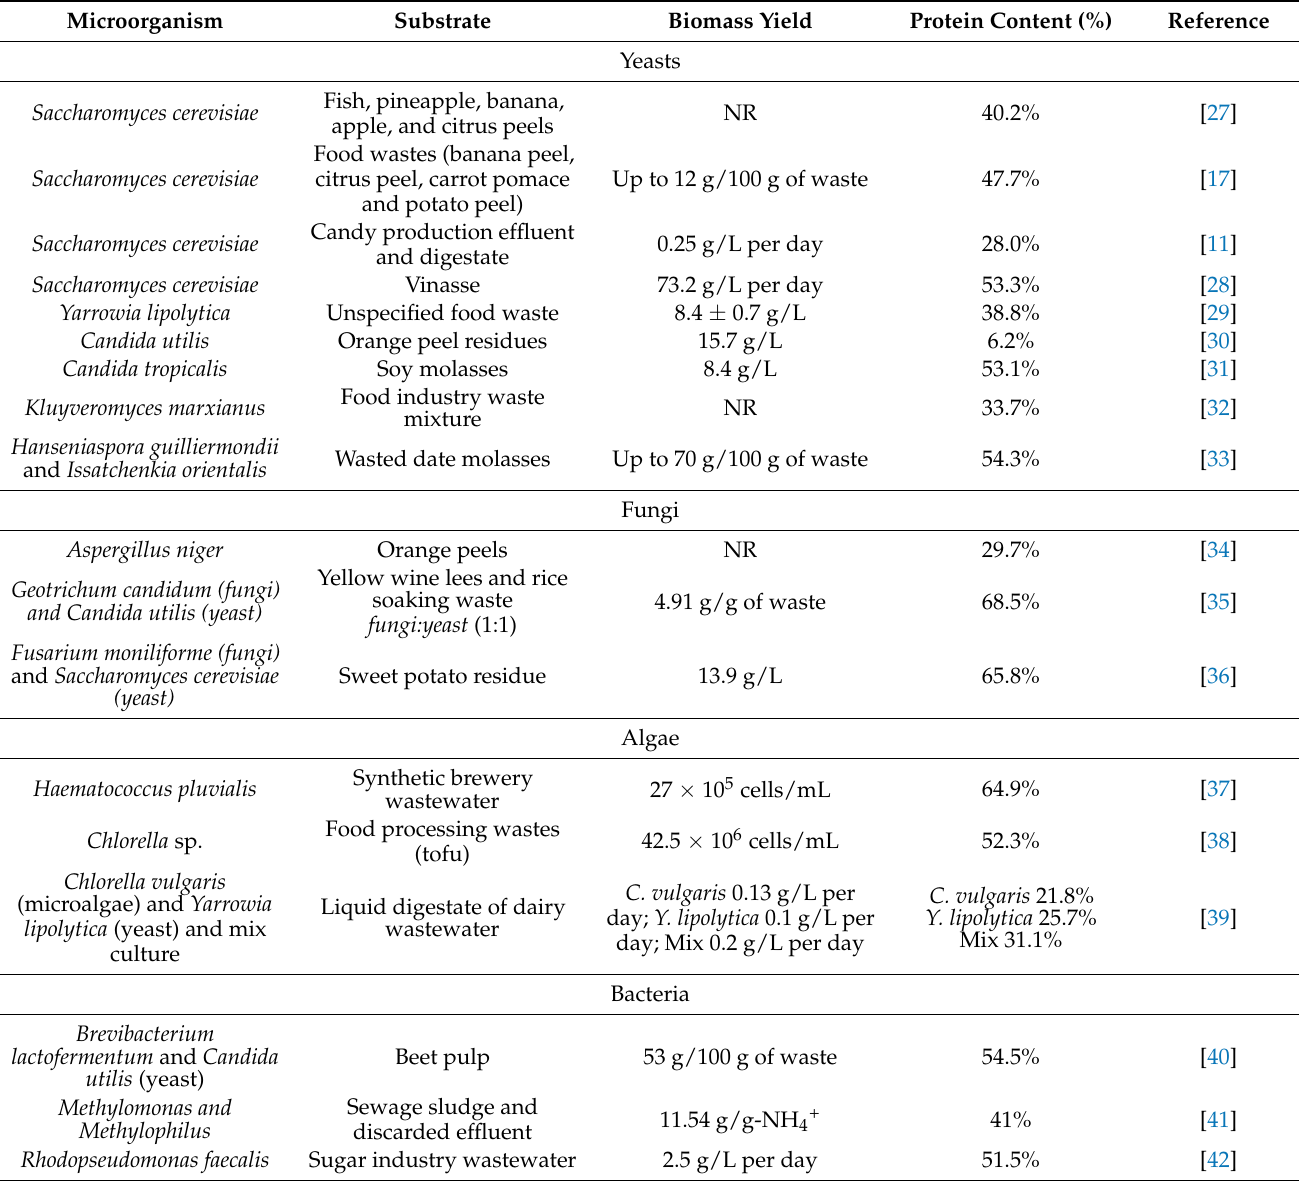
Table 1. Previous research where food waste was used as substrate to produce